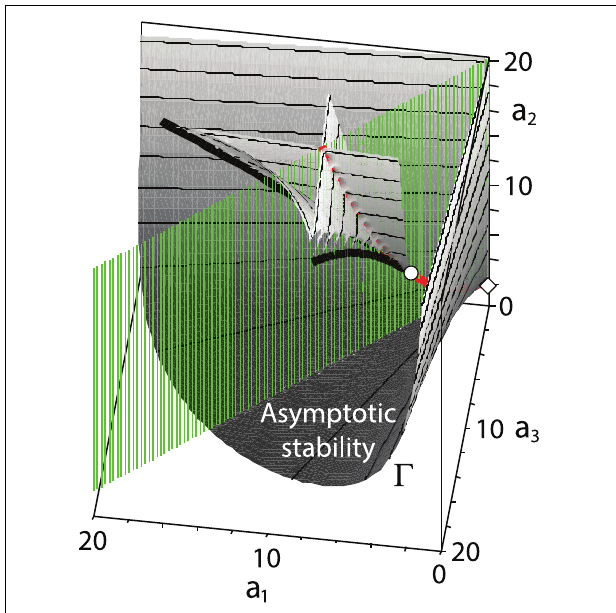
FIGURE 1 | A singular boundary (cid:2) of the domain of asymptotic stability (4) of the polynomial (5) with the Whitney umbrella singularity at the point ( a 1 , a 3 , a 2 ) = ( 0 , 0 , 2 ) , marked by the diamond symbol. Inside the domain of asymptotic stability a part of the discriminant surface of the polynomial is situated with the Swallowtail singularity at the point ( 4 , 4 , 6 ) marked as an open circle. Inside the spike bounded by the discriminant surface all the roots of the polynomial (5) are real and negative. The green planar sector is the tangent cone (10) to the domain of asymptotic stability at the Whitney umbrella